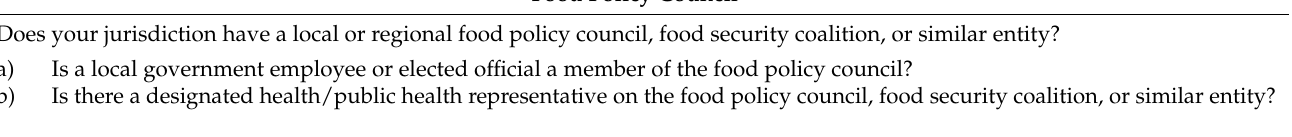
Table 1. Survey questions about food policy councils (FPCs) and municipal policies and practices that support access to healthy foods, National Survey of Community-Based Policy and Environmental Supports for Healthy Eating and Active Living, United States,